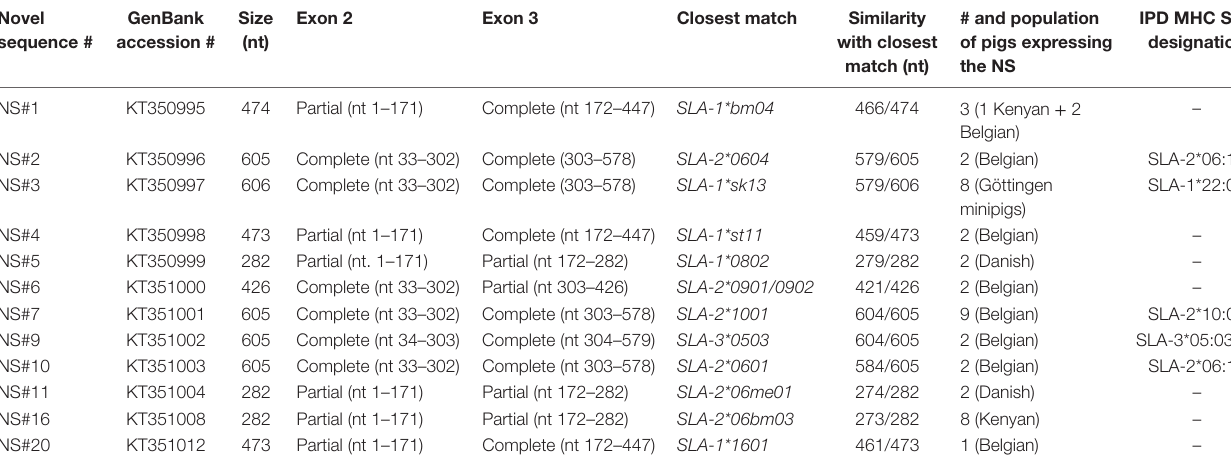
Table presenting the length of the sequences as well as the part of exon 2 and 3, which were sequenced. Displayed is also the closest matching SLA class I allele and similarity with it. Furthermore, the number of pigs, the population from which each novel sequence was detected along with the ISAG allele designation is listed. –, not designated due to insufficient sequence data.